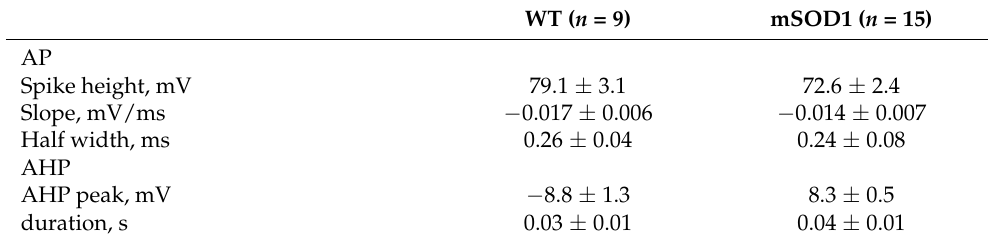
Table 3. AP characteristics of MesV in a 12-week-old mouse model of